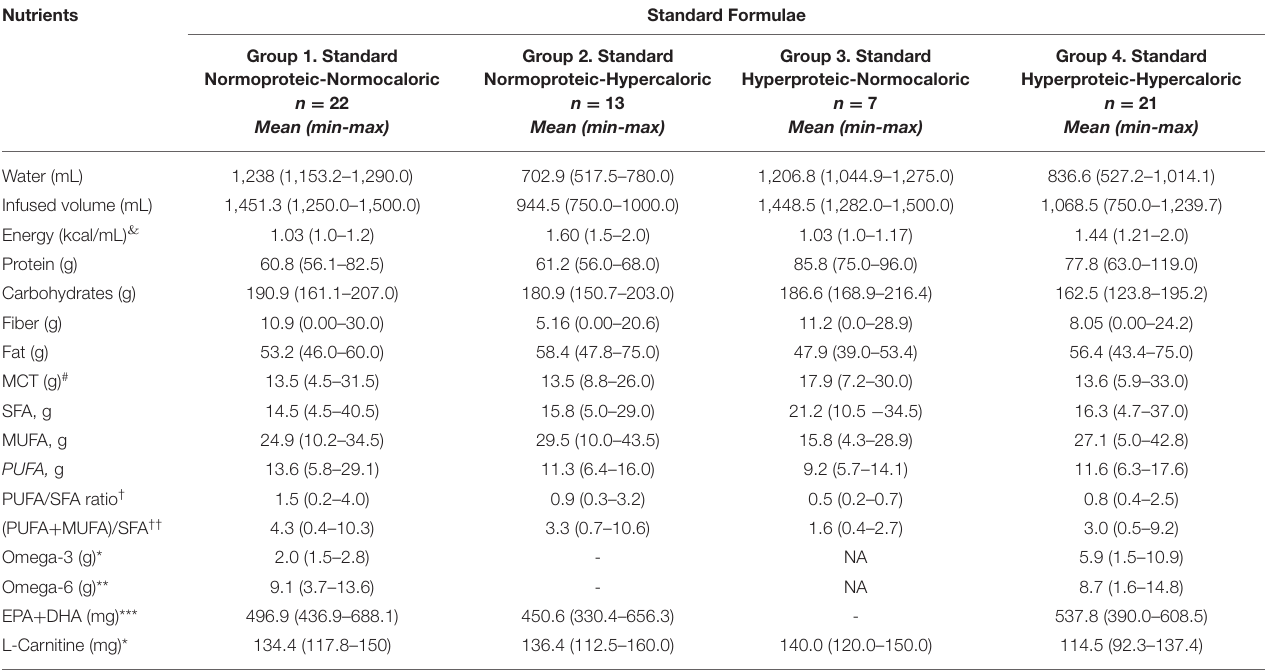
TABLE 1 | Macronutrient distribution, fatty acid profile, fat quality ratios, and some immune-modulatory nutrients content in standard formulae a .